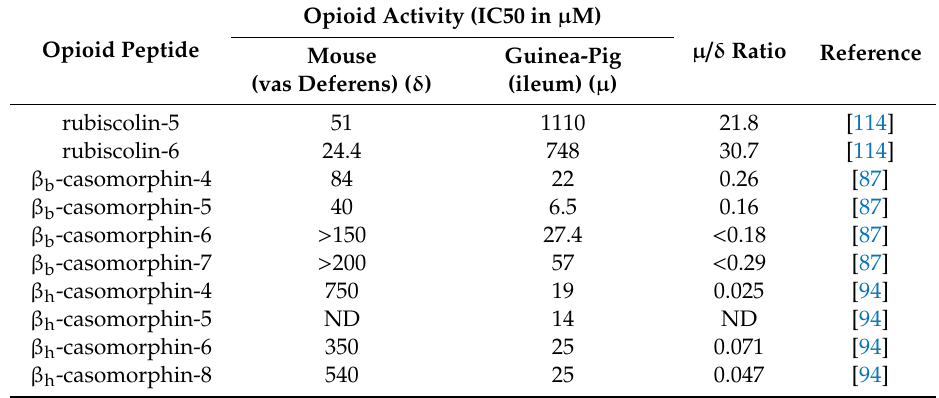
Table 4. The opioid activity of exogenous peptides (IC50 in µ